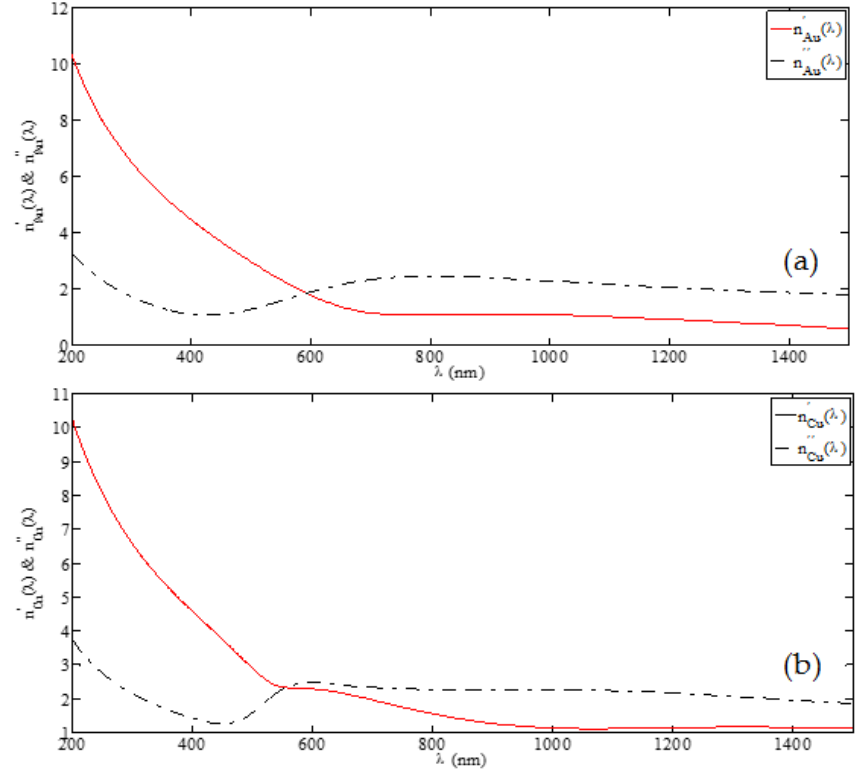
Figure 2. RI dependence on wavelength for ( a ) gold Au and ( b ) copper